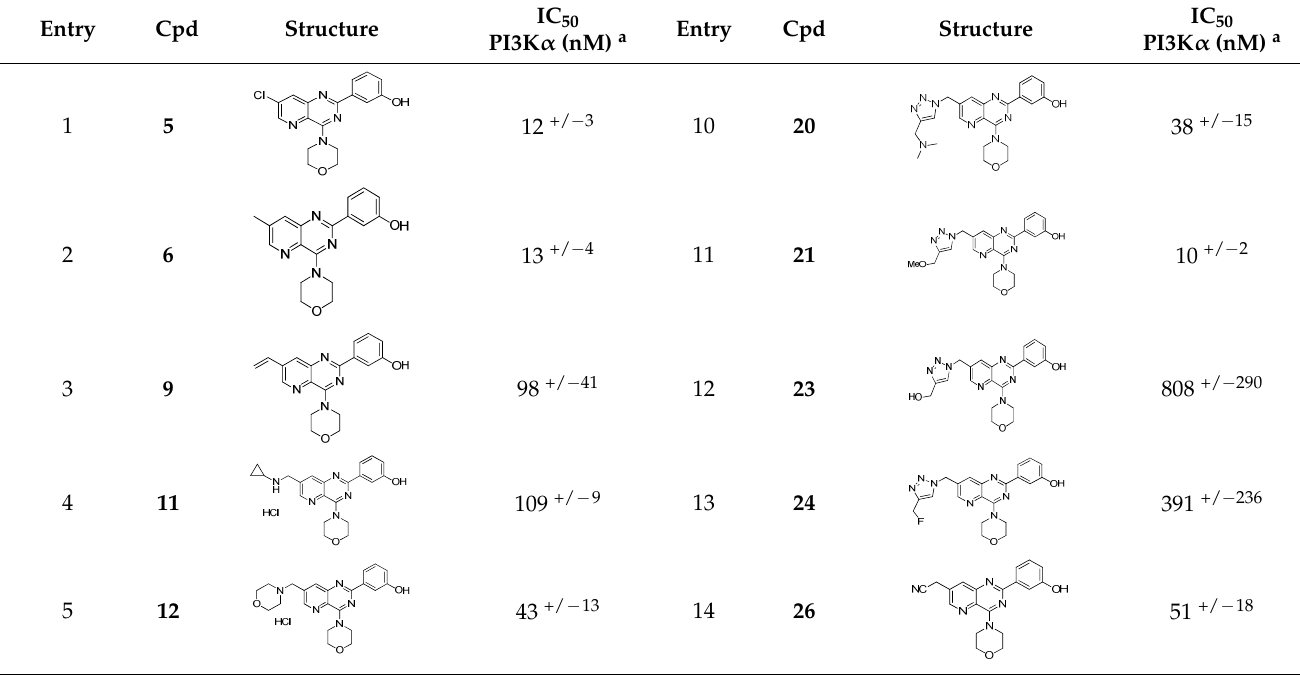
Table 1. Evaluation of PI3K inhibition.